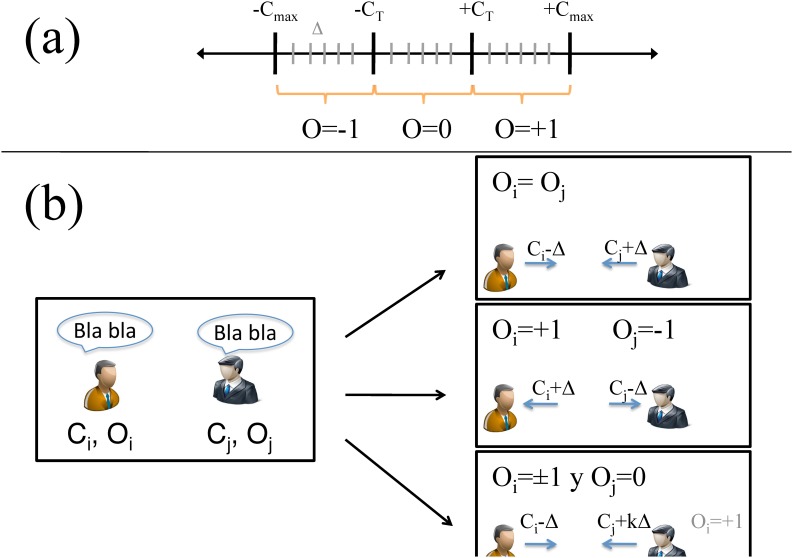
Schematic representation of the opinion dynamics.Panel (a): Relation between persuasion (C) and opinion (O). Each persuasion interval ([−C
max, C
−T], [−C
 − T, C
T],[C
T, C
max]) defines one of the three opinion values (O = −1, 0, +1 respectively). Moreover, each interval is divided in sub-intervals of length Δ. Panel (b): Description of how persuasion is modified via pairwise interactions in three different cases: Same opinion (top panel), opposing opinions (middle panel) and formed opinion vs undecided.